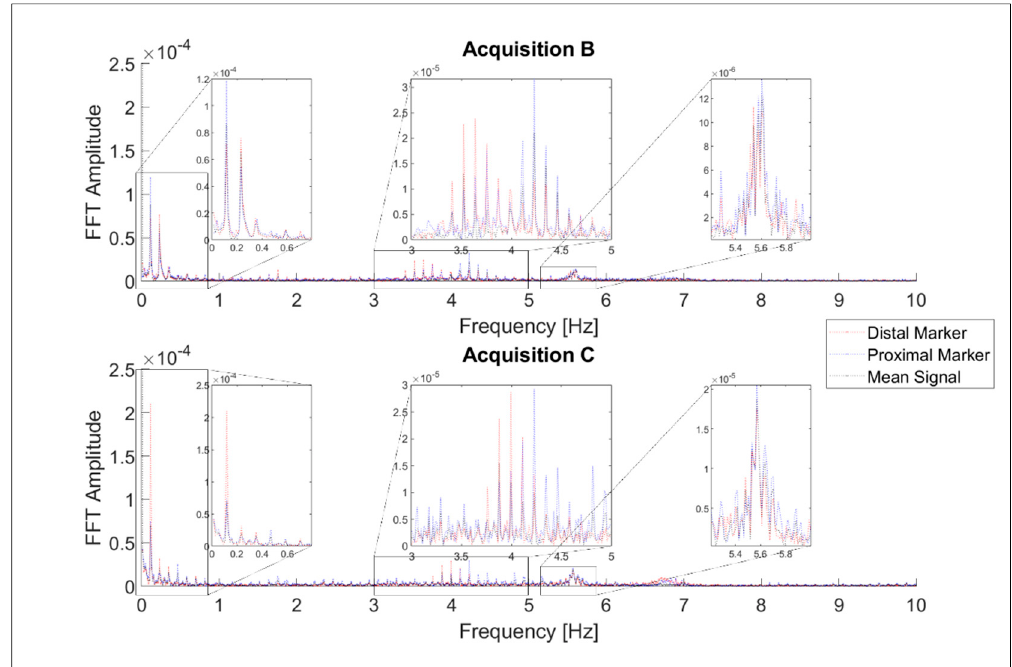
Figure 4. Frequency spectrum of the displacement signals of distal and proximal device markers, and of their mean profile.